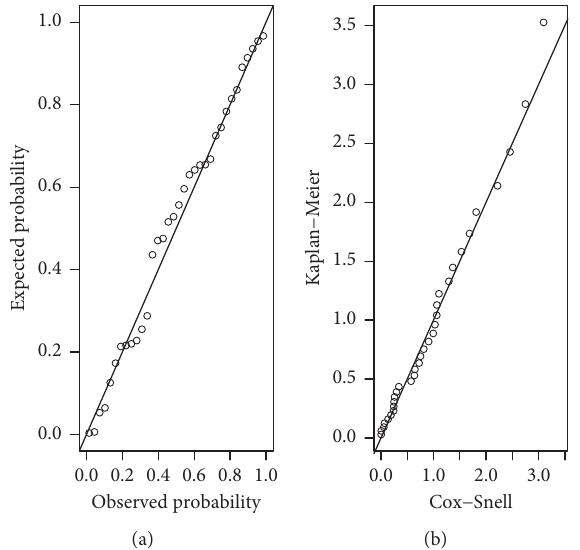
Figure 8: P-P plot (a) and Cox–Snell versus − log of Kaplan–Meier estimates